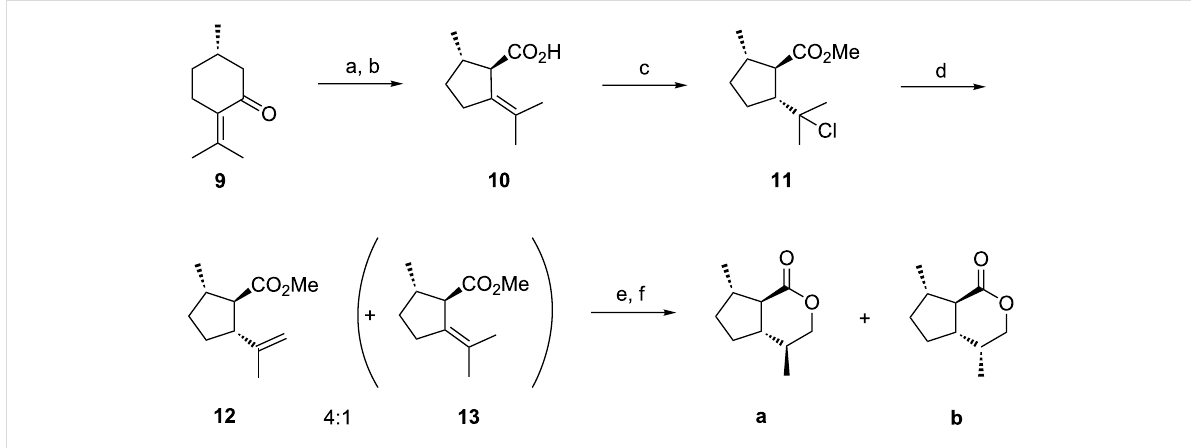
Scheme 1: Route from ( S )-pulegone to the mixture of dihydronepetalactones a and b , consequently following Wolinsky's approach [23]. Reaction conditions: a) Br 2 , HOAc, 0 °C; b) KOH, H 2 O, reflux (15%, 2 steps); c) MeOH/HCl, rt, 96 h (82%); d) 2,6-lutidine, reflux, 72 h (75% of 12 + 13 ); e) BH 3 ·SMe 2 , 0 °C, THF, NaOH, H 2 O 2 (86% mixture of diastereomers); f) p -TsOH, toluene, reflux (17% of a + b).